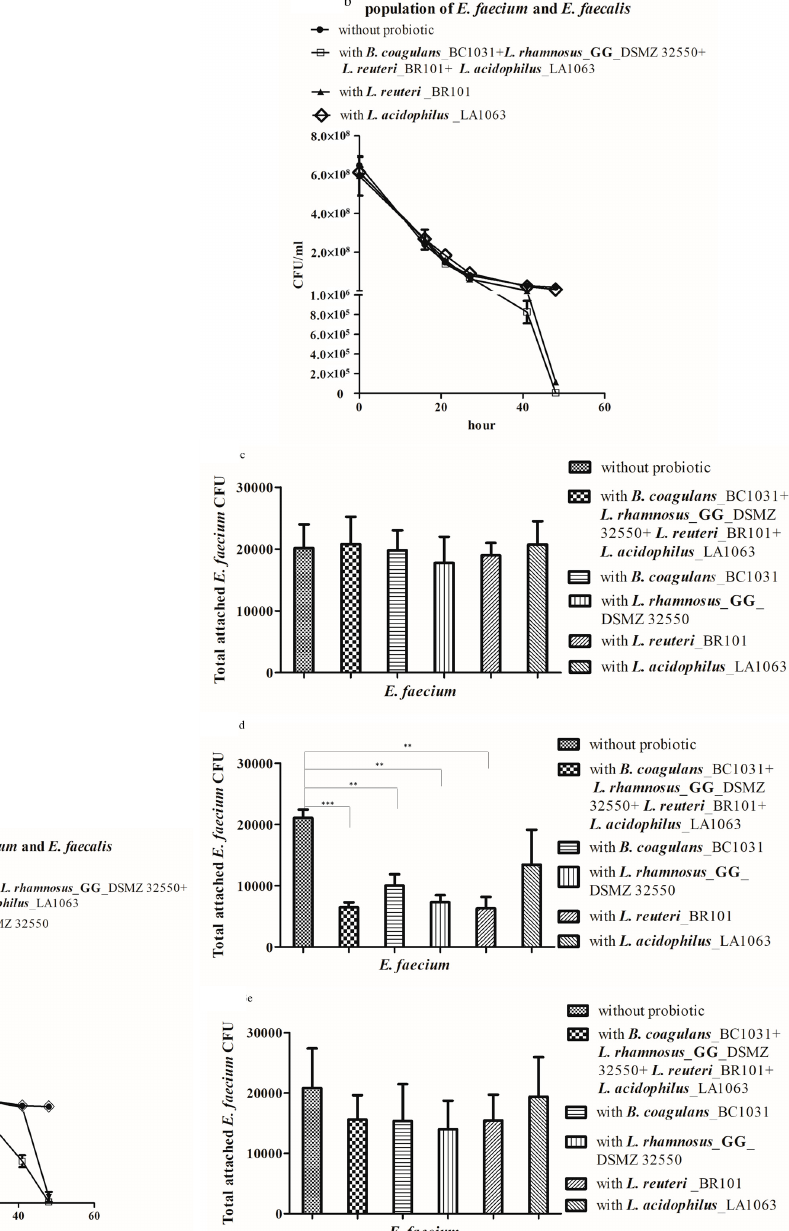
Figure 3. The combination of four probiotic strains showed better e ffi cacy than that of individual strains against co-cultured VRE. Individual strains of ( a ) B. coagulans_ BC1031 or L. rhamnosus GG_ DSMZ 32550, ( b ) L. reuteri_ BR101 or L. acidophilus_ LA1063 were compared with the combination of